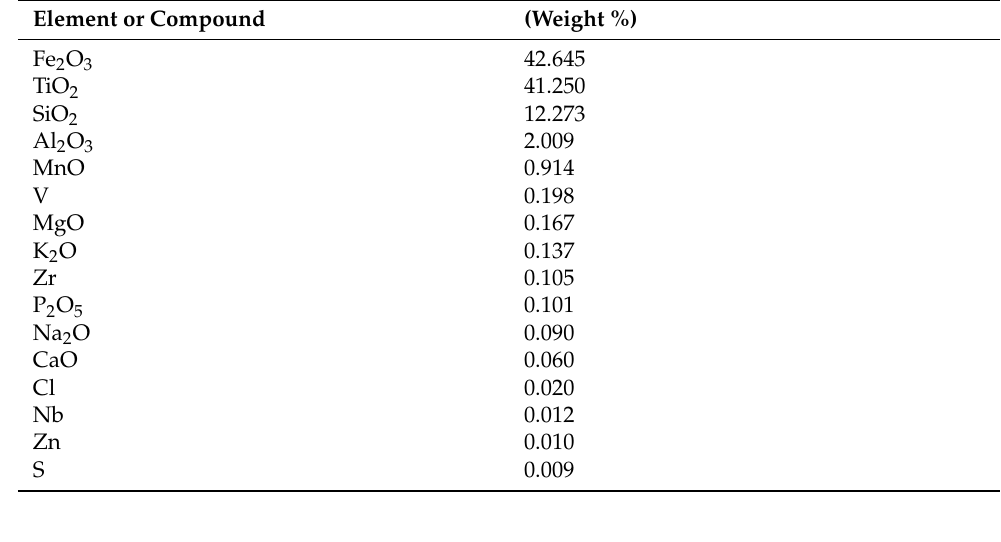
Table 2. XRF results for ilmenite.